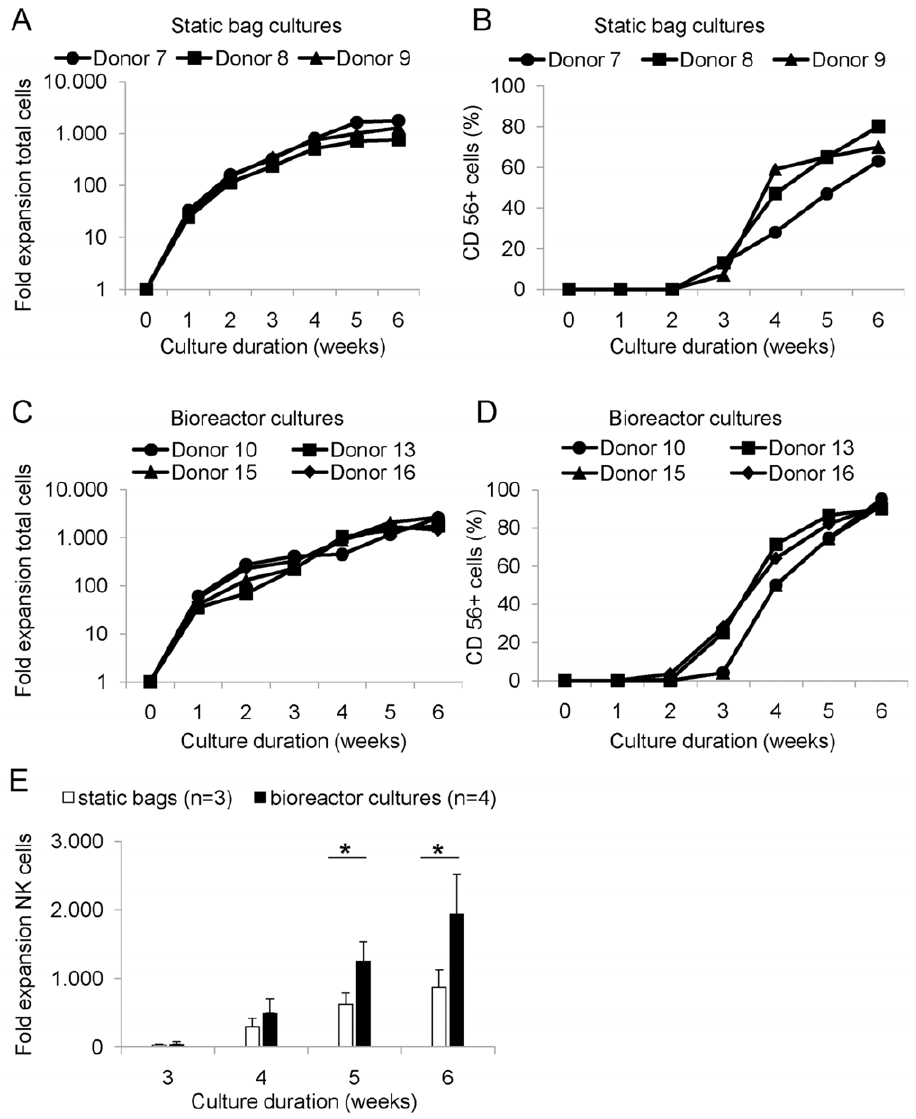
Figure 1. Ex-vivo generation of CD56 + NK cells from cryopreserved CD34 + UCB cells. CD34-enriched UCB cells were expanded for two weeks and subsequently differentiated into NK cells for four additional weeks. Cell cultures were weekly analyzed for cell numbers and phenotype using flow cytometry. ( A ) Fold expansion of total cells for each donor after initial seeding of enriched CD34 + UCB cells during 6 weeks of culture using static Vuelife TM cell culture bags. ( B ) CD56 + cell frequency for each donor during the 6 week culture period for static bag cultures. ( C ) Fold expansion of total cells for each donor after initial seeding of enriched CD34 + UCB cell population during 6 weeks of culture using single use bioreactors. ( D ) CD56 + cell frequency for each donor during the 6 week culture period for bioreactor cultures. ( E ) Mean total CD56 + NK cell expansion during 4 weeks of differentiation using static bag (n=3) or bioreactor cultures (n=4). Data are depicted as mean 6 SD. The asterisk (*) represents a p-value of , 0.05.